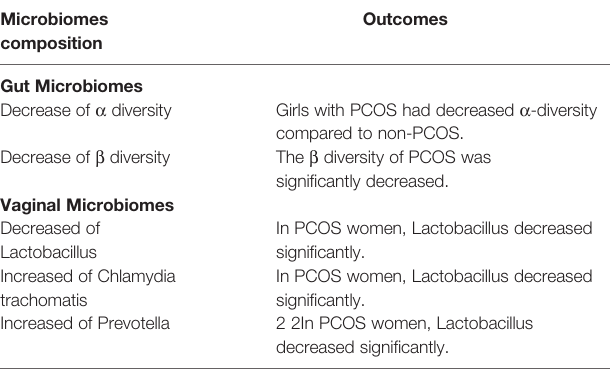
TABLE 1 | Summary of composition changes of microbiomes in PCOS. Microbiomes composition